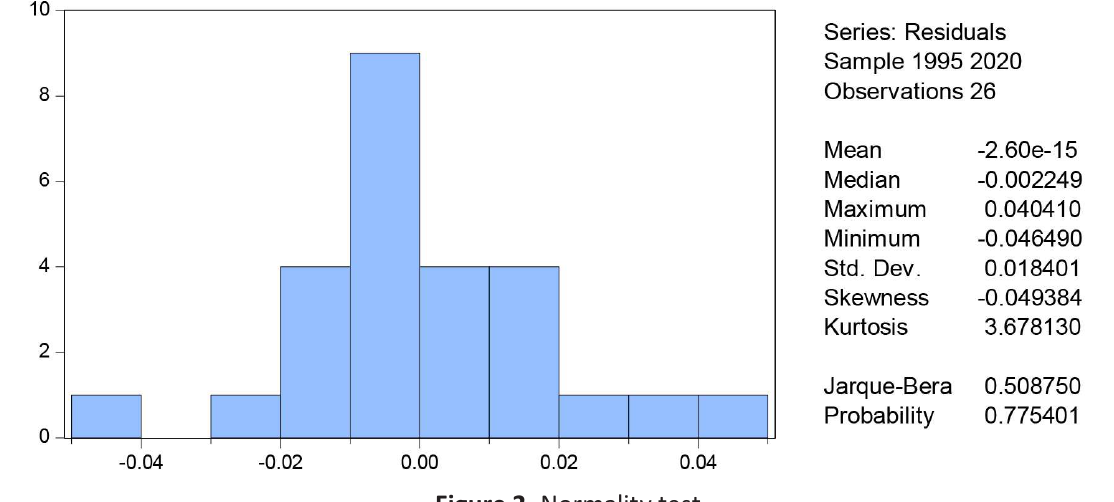
Figure 2. Normality